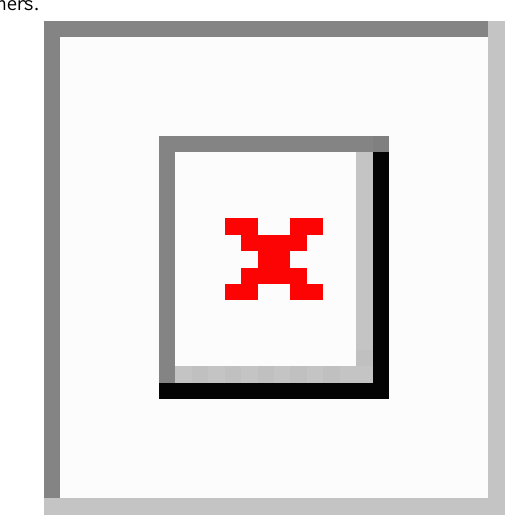
Figure 1. The number of possible triads among an individual’s sex